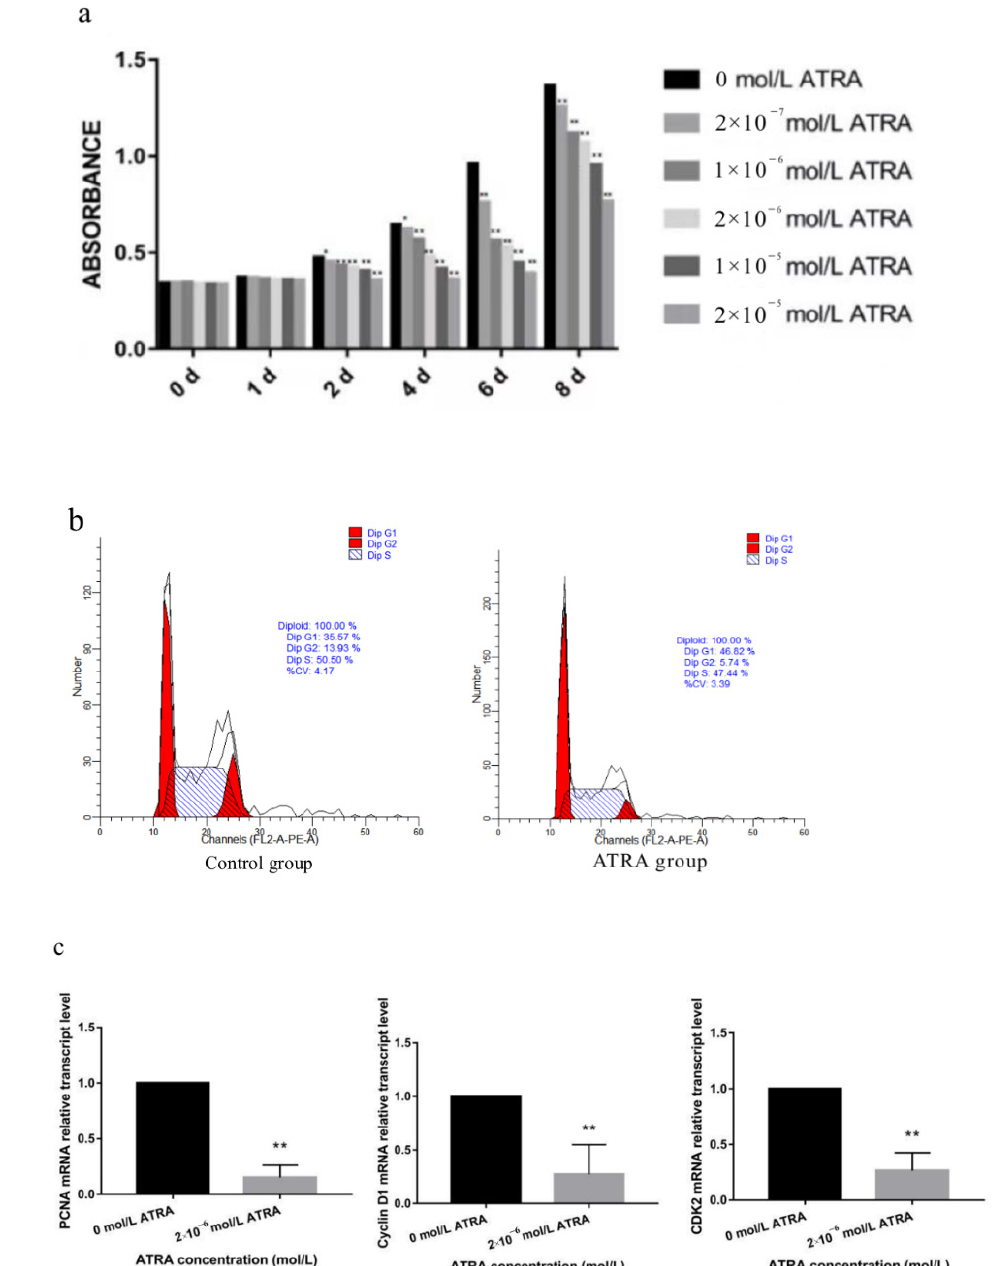
Figure 1. Effect of ATRA on the proliferation of preadipocytes in Yanbian yellow cattle. ( a ) The MTS method was used to determine the effects of different concentrations of ATRA (0, 2 × 10 − 7 , 1 × 10 − 6 , 2 × 10 − 6 , 1 × 10 − 5 , 2 × 10 − 5 mol/L) on the viability of preadipocytes from Yanbian yellow cattle. ( b ) Flow cytometry was used to determine the number of cells in different cell cycle stages. mRNA expression levels of ( c ) PCNA , cyclin D1, and CDK2 . * indicates a significant difference compared with the blank control group, p < 0.05; ** indicates a highly significant difference compared with the blank control group, p < 0.01.